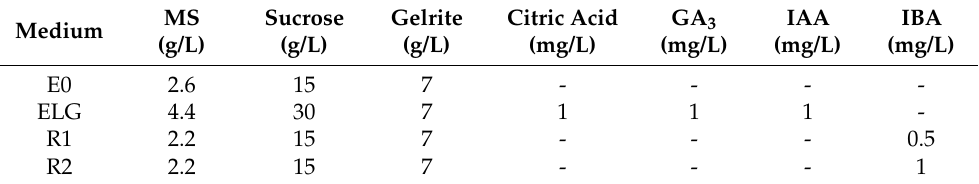
Table 2. Composition of the elongation and rooting means used in the preliminary tests. Medium